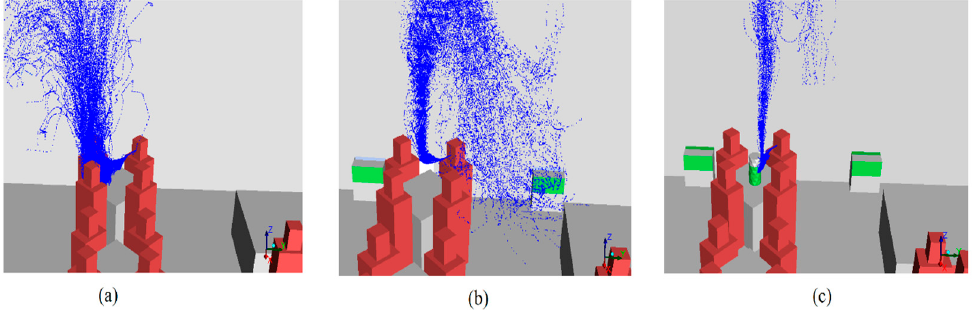
Figure 8. The dispersion processes of virus-carrying particles under three ventilation conditions: ( a ) CA; ( b ) CAF; ( c ) CAFT.